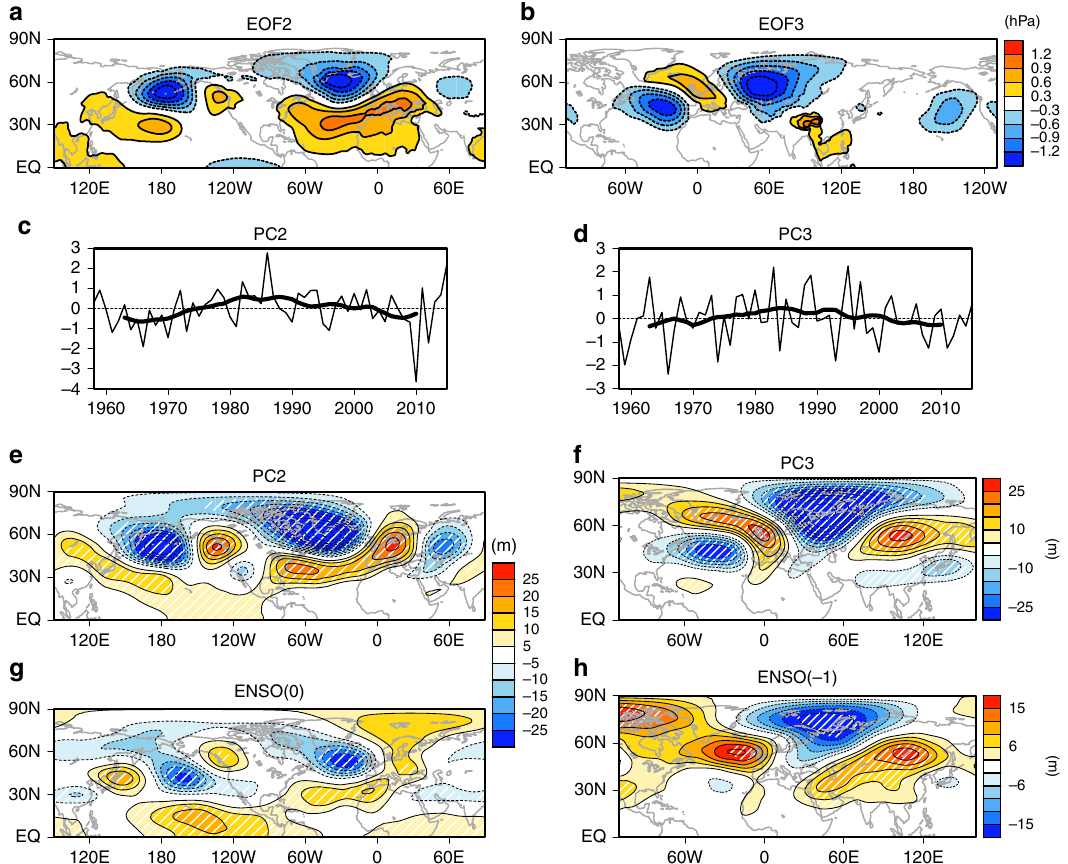
Fig. 2 Two major modes of Northern Hemisphere circulation in early winter. a EOF-2 and b EOF-3 of early winter sea level pressure (SLP) and c , d corresponding principal components (PCs) for 1958 – 2015, respectively. Thick black lines in c , d indicate 11-year running means. Regressed anomalies of 300-hPa geopotential height onto PCs of e EOF-2 and f EOF-3, and g ENSO(0), and h ENSO( – 1). Hatching in e – h indicates statistical signi fi cance at the p <0.05